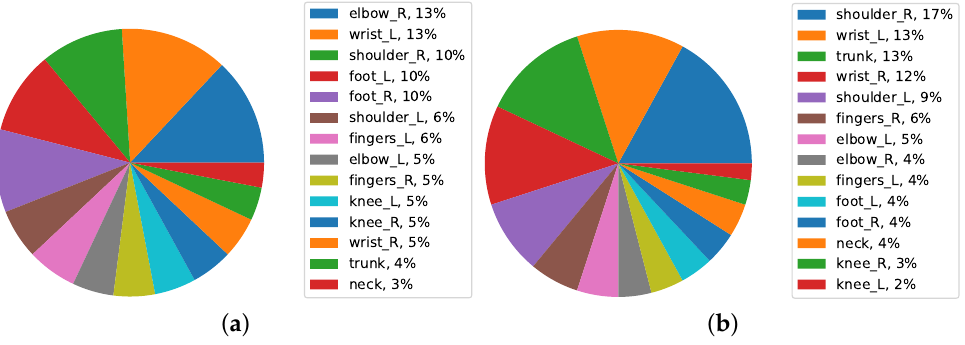
Figure 14. Average FWA of body parts in Special Projects for ( a ) and ( b ) Assembly data.